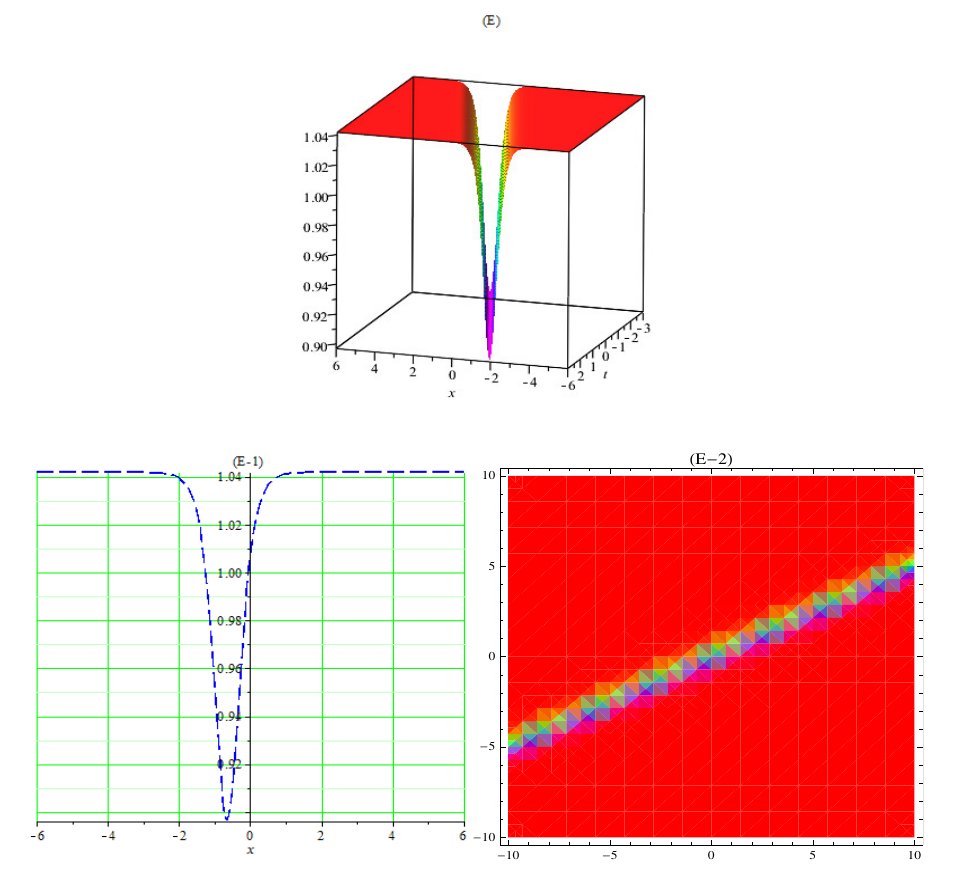
Figure 5. ( E ) 3D graph of dark soliton of (41) using l = 2.2, m = 0.4, µ = 0.6, A = 2.7, ζ = 0.5, V = 0.3. ( E-1 ) 2D plot and ( E-2 ) contour plot of (41).